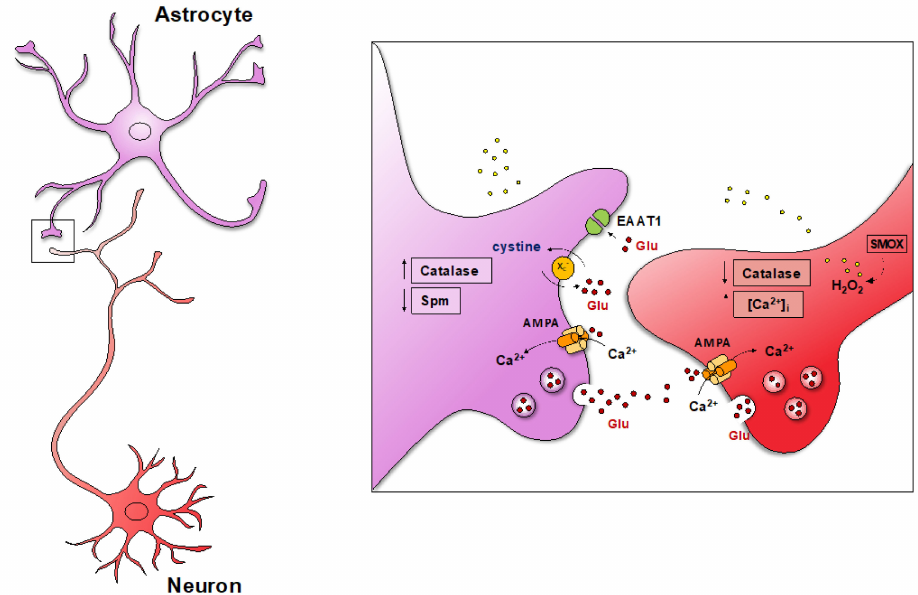
Figure 4. SMOX overexpression in neurons resulted in chronic oxidative and excitotoxic stress and in neuron loss. Schematic representation of the main mechanisms taking place at cerebrocortical glutamatergic synapses in the SMOX-overexpressing mouse model. NeuN positive cells were re- duced [37,121], and a relative increase in the abundance of astrocyte processes and a decrease in nerve terminals (an increase in GFAP, ezrin and vimentin-positive cells vs. a reduction in synaptophysin and NeuN-positive cells) were found. SMOX overexpression in neurons leads to oxidative stress in neu- rons, increased by an ROS response in astrocytes and leading to the depletion of catalase (a reduction in the antioxidant defence in nerve terminals). A defective control of the AMPA-evoked intracellular Ca 2+ response in the nerve terminals can exacerbate the reactive astrocytes-dependent excitotoxic mechanism activation. For further details, see the text. AMPA, alpha-amino-3-hydroxy-5-methyl-4- isoxazole-propionic acid receptor; Glu, glutamate; SMOX, spermine oxidase; Spm,